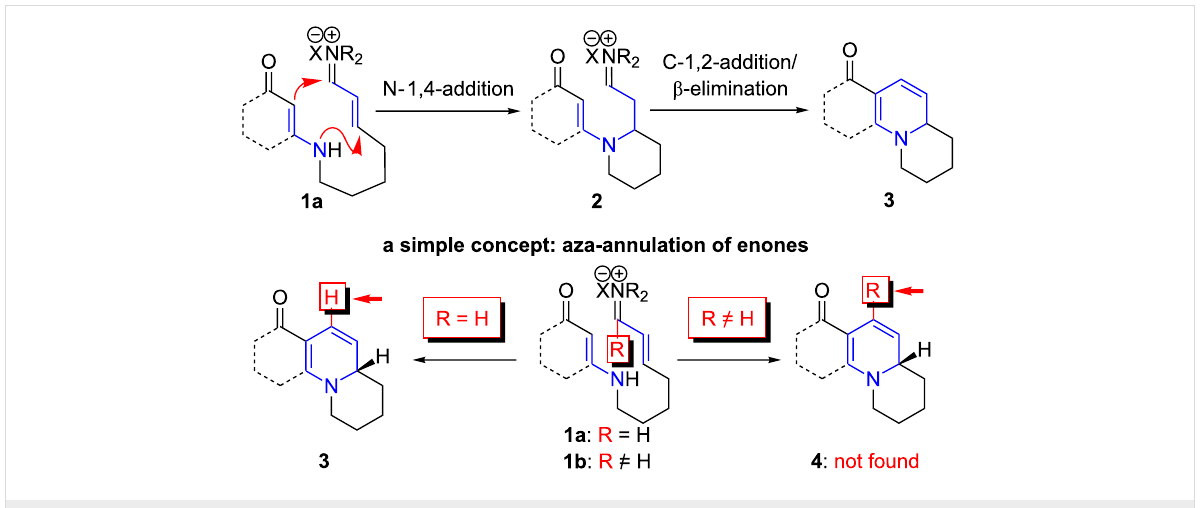
Scheme 1: Aza-[3 + 3] annulations with